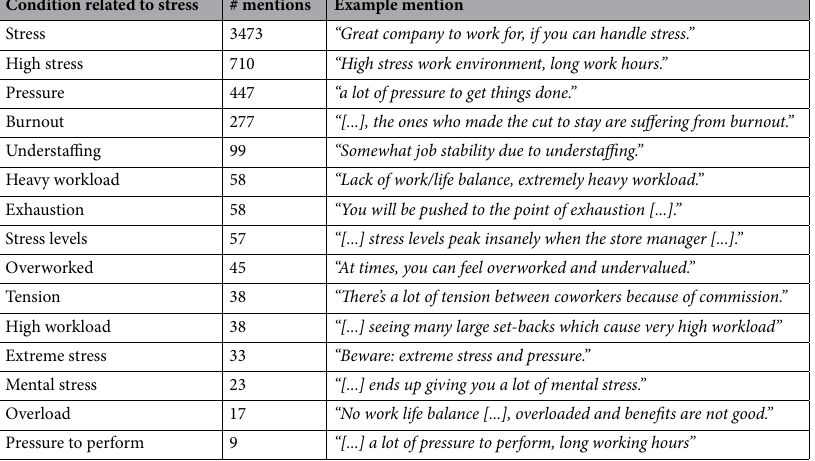
“At times, you can feel overworked and undervalued.” “There’s a lot of tension between coworkers because of